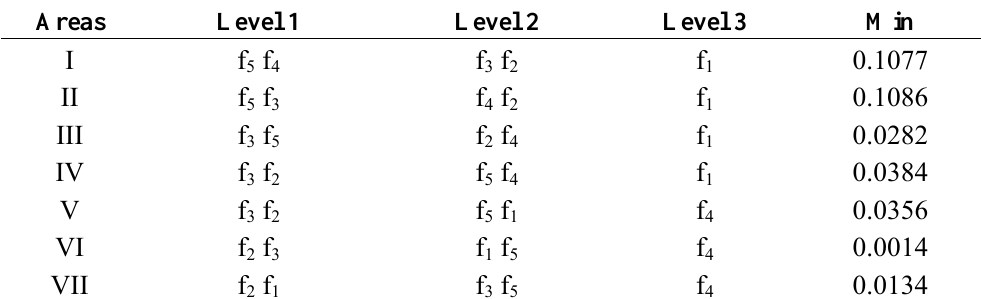
Table 4. Optimization results.